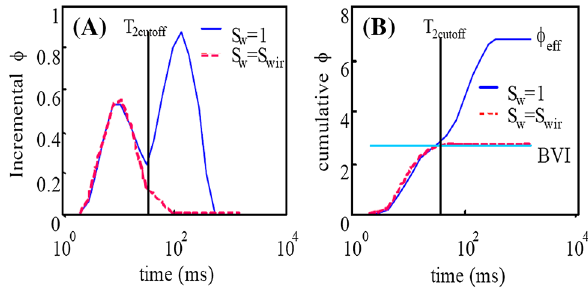
Fig. 10 Illustration of T 2 cutoff estimation process with NMR core measurements. a Incremental distribution and b cumulative distribu- tion (after Chen et al. 1998) Table 1 Typical clastic pore Pore geometry and surface to volume analysis